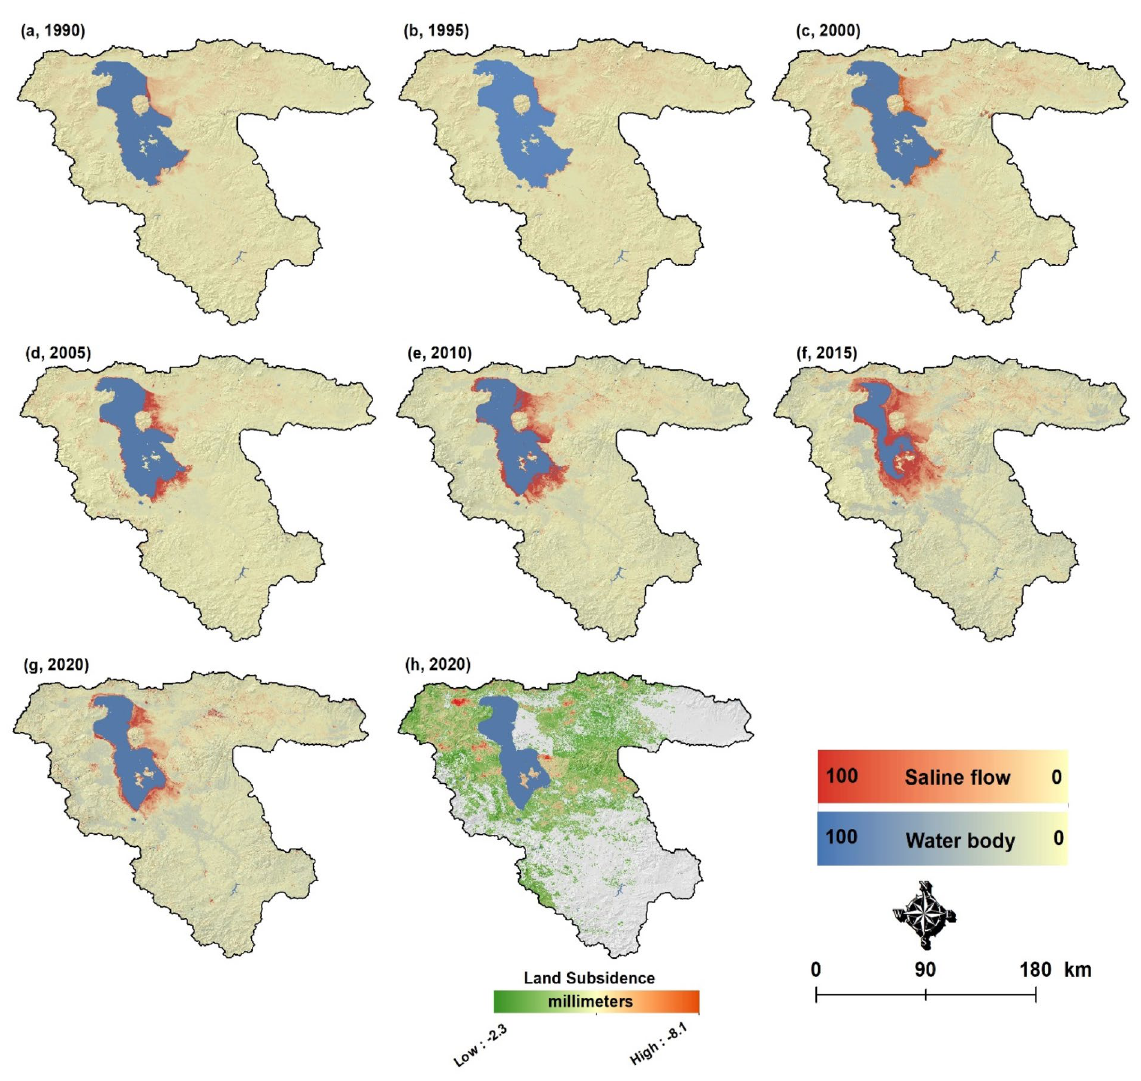
Figure 4. Results of the soil salinization from 1990–2020 ( a – g ) and land subsidence from 2915–2020 ( h ). Red indicates the propagation of saline flows that have significantly impacted the productivity of farmlands. Figure created in Arc GIS 10.7 ESRI, https:// www. esri.